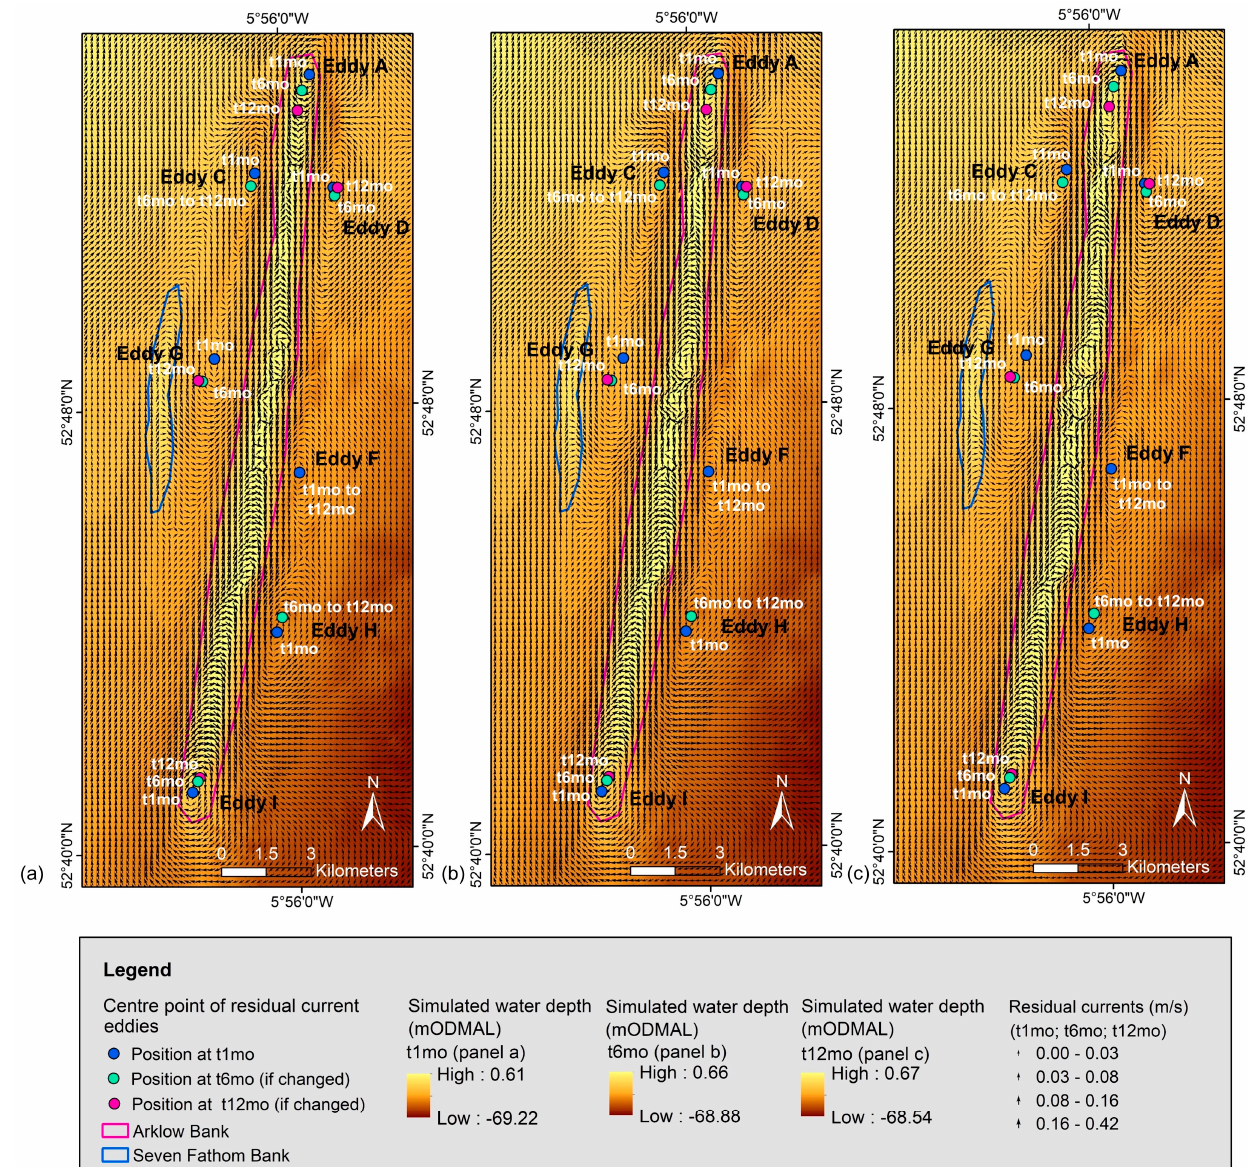
Figure 5. Simulated residual currents for the ( a ) first (t1mo), ( b ) sixth (t6mo) and ( c ) twelfth (t12mo) month of a one-year simulation period. Simulated bed levels at the end of each simulated month are also presented; t1mo is the simulated bed level at the end of the first month.